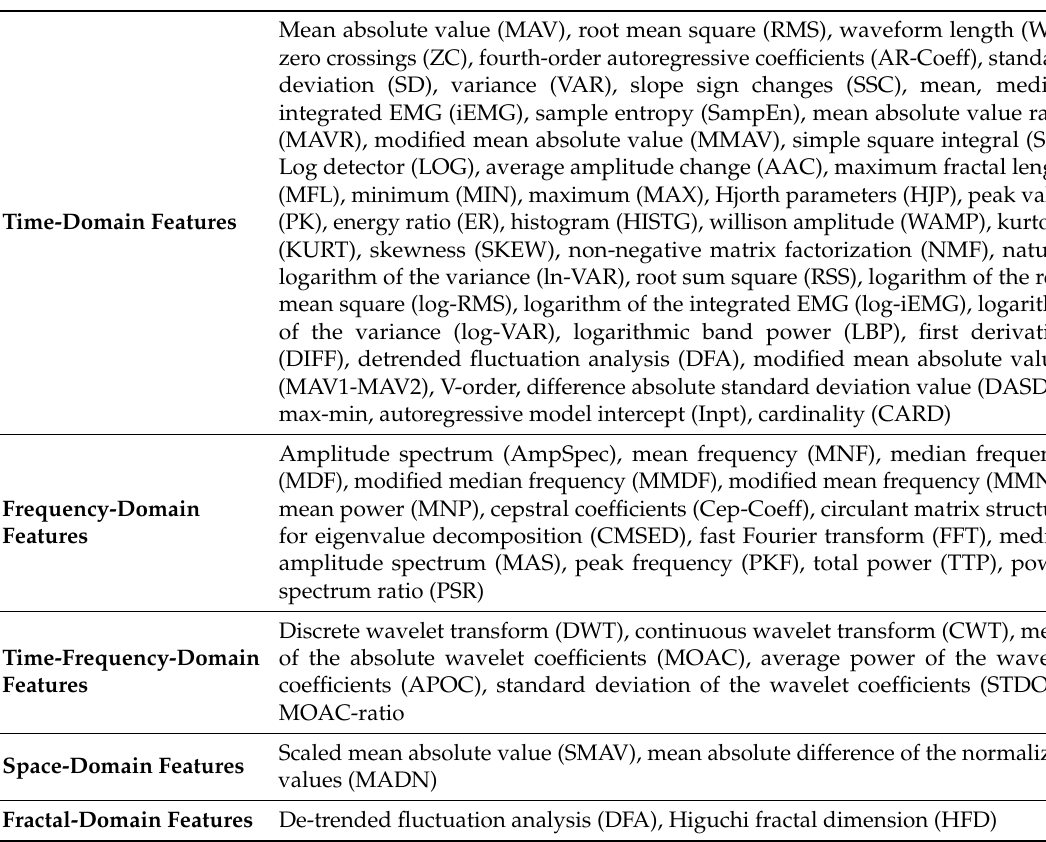
Table 8. Features according to the domain.